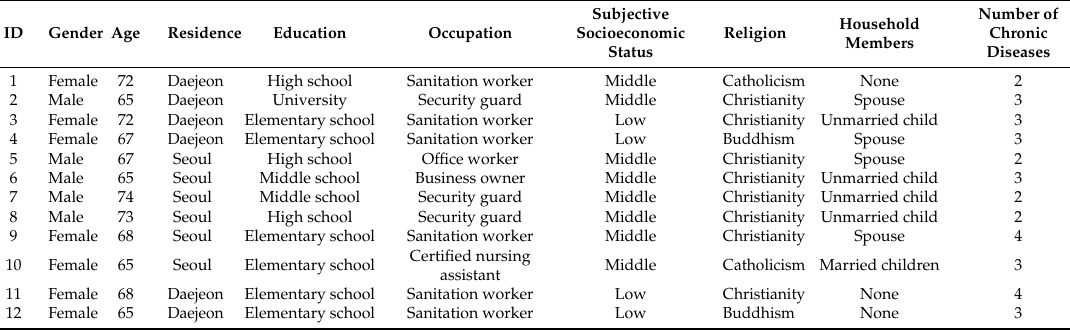
Table 1. General characteristics of